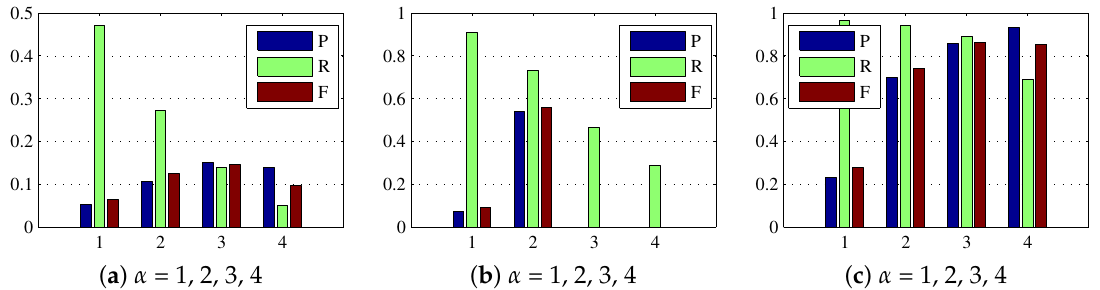
Figure 5. Precision, recall, and F-measure bars for the sparse reconstruction maps under different values α . ( a – c ) denote the results on Sequence 1, Sequences 2 and Sequence 3